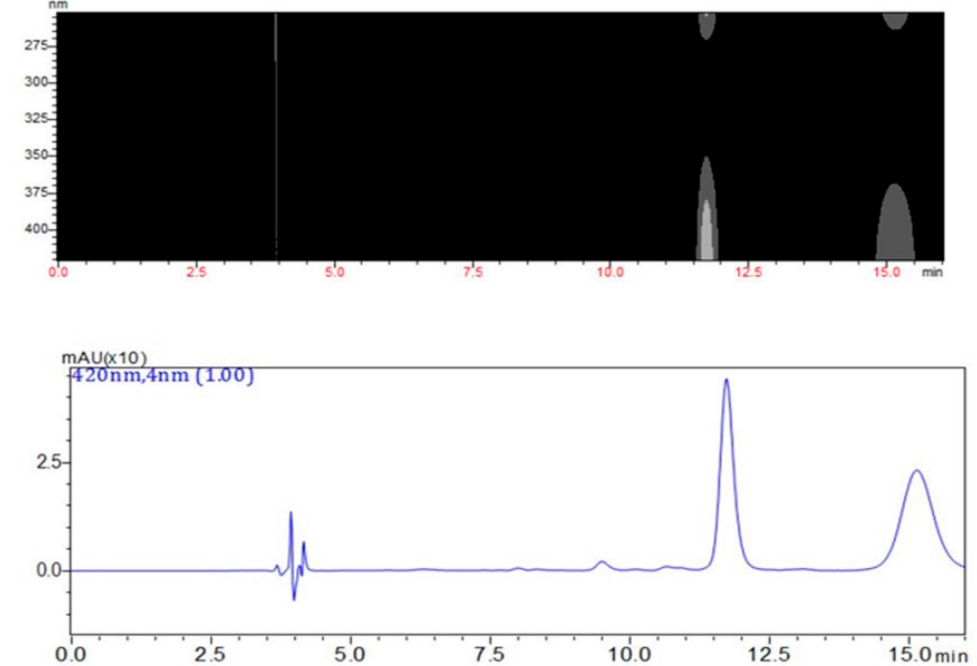
Figure 2. Above, diode array detection of the chromatogram acquired within the wavelength detection window. The extract of PAVARINI I afforded this result. Maximum λ values can be noted at 270 nm and 420 nm. Below, extracted chromatogram at λ 420 nm displaying two QMTs, maytenin (Rt 11.7 min) and pristimerin (Rt = 15.0 min), and one SPA, aquifoliunin E1 (Rt 9.6 min). Results from the 1 H-NMR spectra of all samples showed similar chemical shifts between maytenin ( 1 ) and pristimerin ( 2 ), with major differences on the aromatic signals of rings A and B, the presence of a singlet from the methoxyl hydrogens of pristimerin at δ 3.48 ( s , 3H, H-29) and the significant